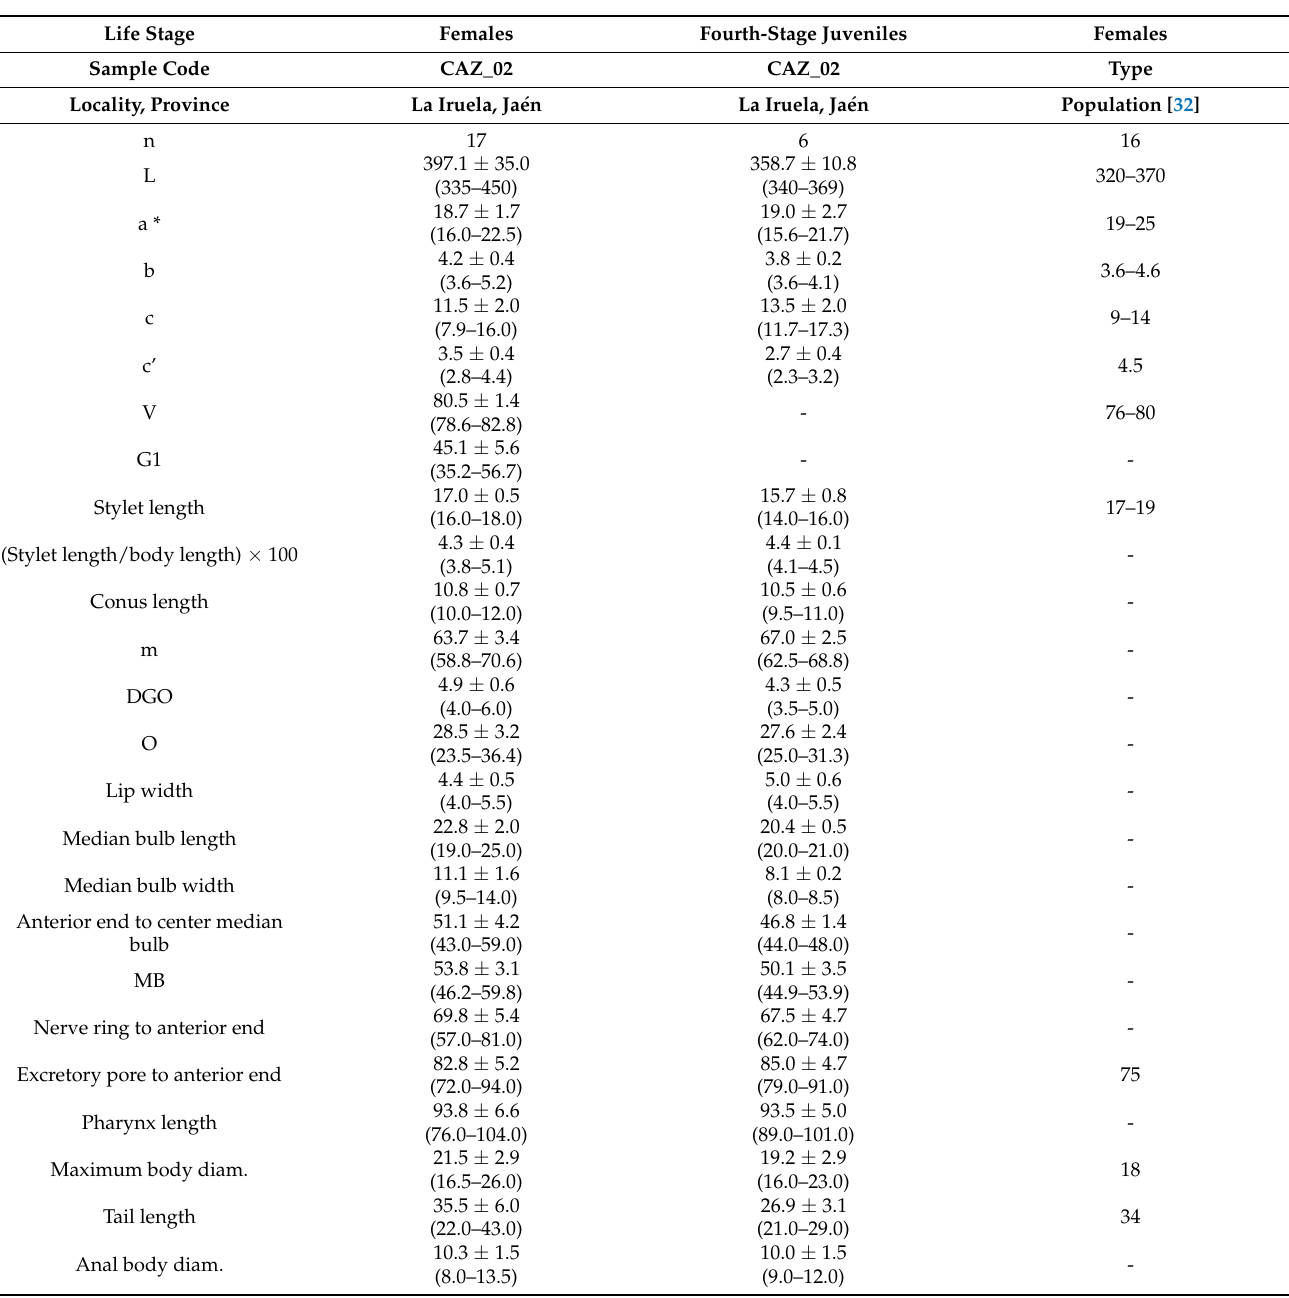
Table 4. Morphometrics of Paratylenchus amundseni Bernard, 1982 from La Iruela, Ja é n, Spain. All measurements are in µ m and in the form: mean ± s.d.